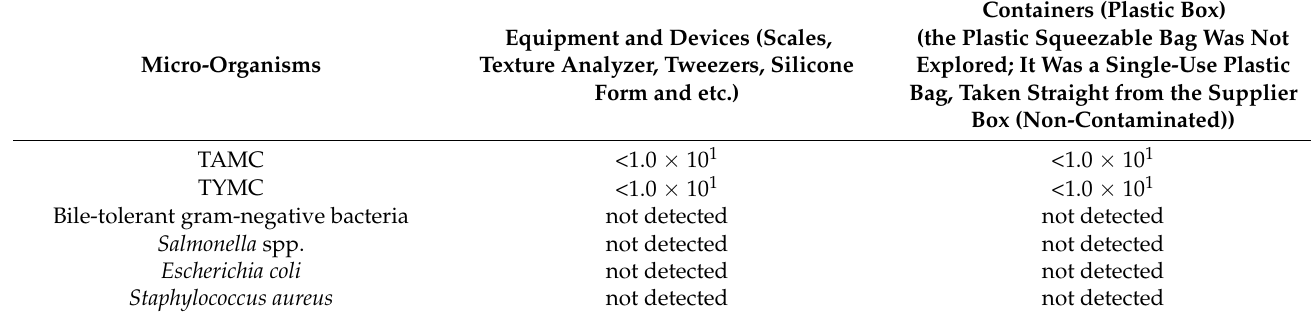
Table 2. Chewable gel tablets’ composition.